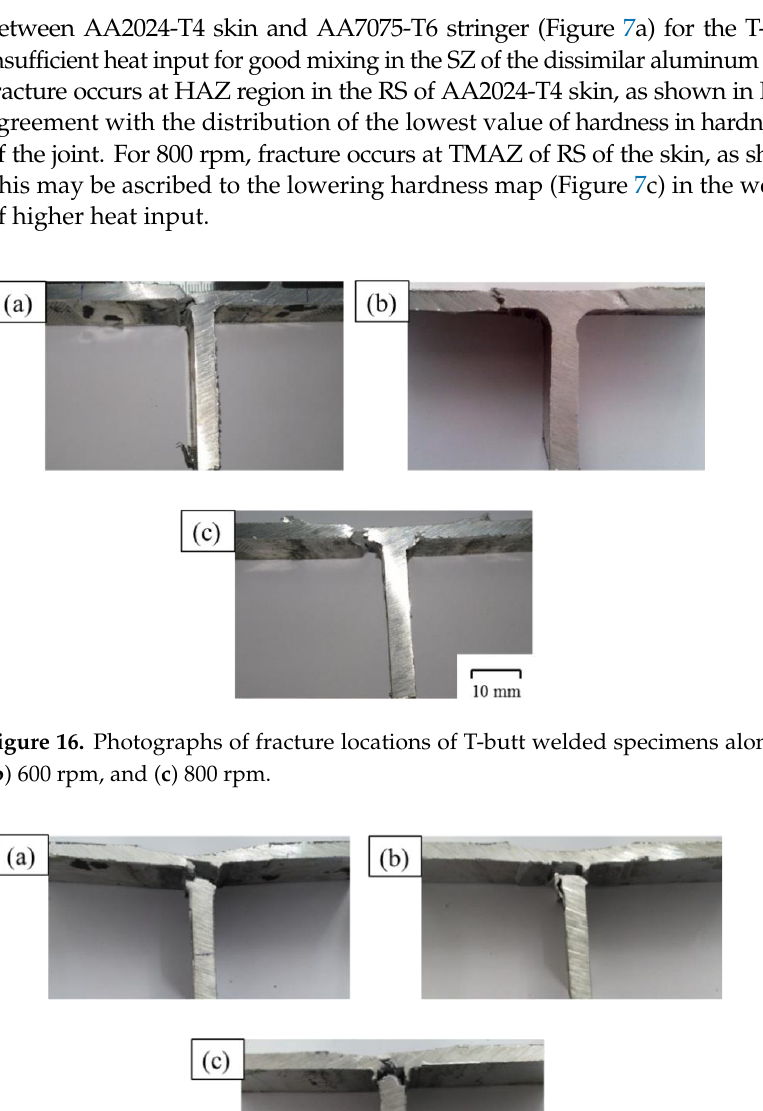
Figure 17. Photographs of fracture locations of T-butt welded specimens along stringer . ( a ) 400 rpm, ( b ) 600 rpm, and ( c ) 800 rpm.